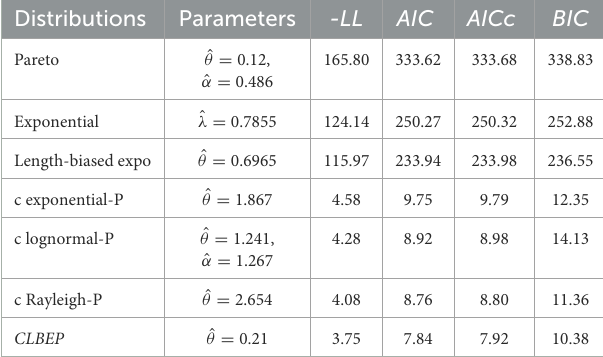
TABLE 3 Test for ˆ θ 2 = 4.9812.